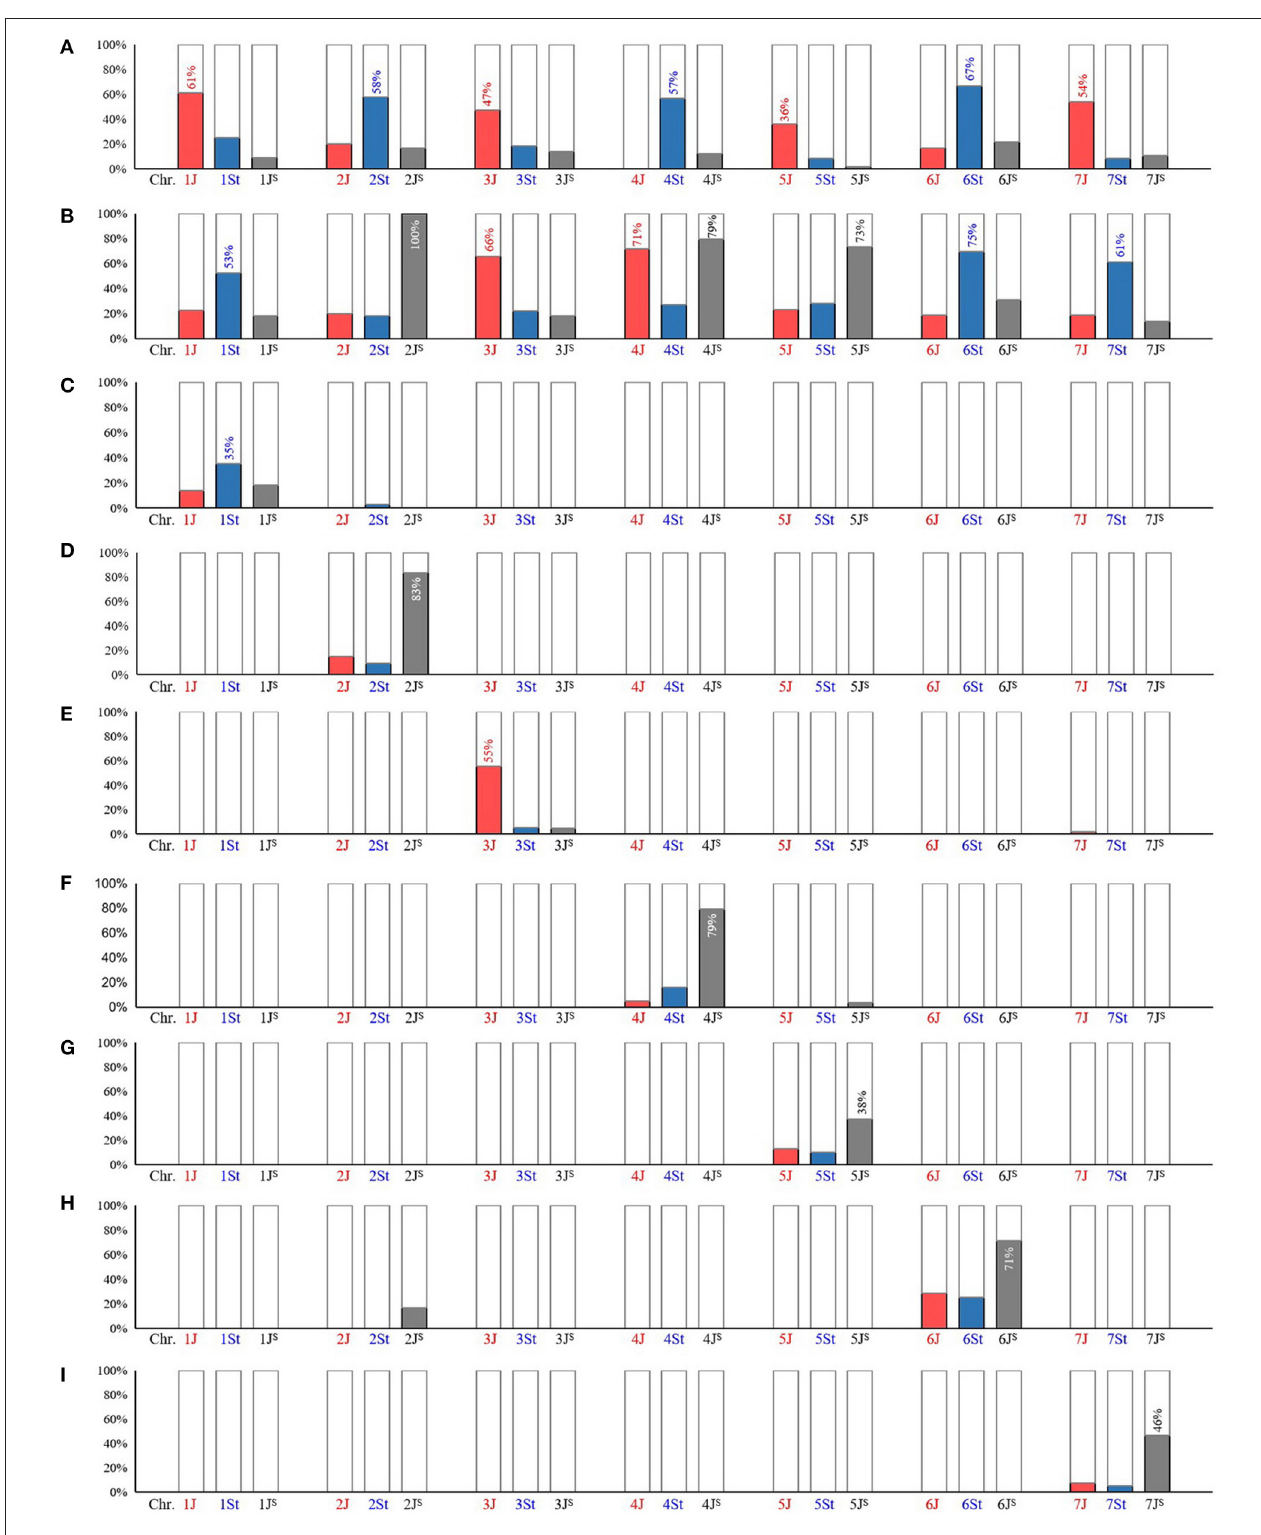
FIGURE 3 | Amplification of Thi -specific markers in wheat- Th. intermedium introgression lines. (A) partial amphiploid TAF46 (ABD + 1J + 2St + 3J + 4St + 5J + 6St + 7J); (B) partial amphiploid TE-3 (ABD + 1St + 2J s + 3J + 4J + 4J s + 5J s + 6St + 7St); (C) substitution line AS1677 [ABD + 1St(1D)]; (D) addition line X24C14 (ABD + 2J s ); (E) addition line A1082 (ABD + 3J); (F) substitution line A1125 [ABD + 4J s (4B)]; (G) translocation line A39 (ABD + T4BS.5J s L); (H) substitution line XM-4 [ABD + 6J s (6B)]; (I) translocation line Z4 (ABD + T7J s S-3AS.3AL + T7J s S.7J s L-3AL). The sub-genomes with the largest proportion of positive markers were labeled, and the numbers on the column were significantly different from the two other observations within the same homologous group (HG) at p ≤ 0.0125 level (Bonferroni corrected).